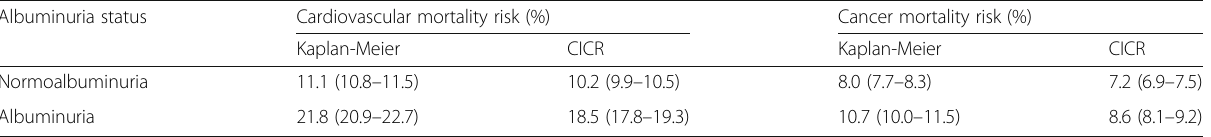
Table 2 Nine-year absolute risk estimates (and 95%CIs) for cardiovascular and cancer mortality from Kaplan-Meier and cumulative incidence competing risk